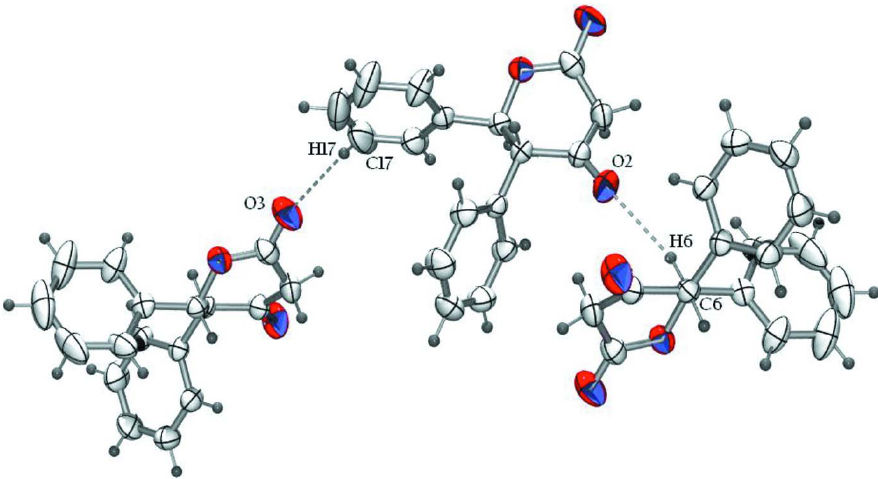
H O , showing the atom labelling with 50% probability displacement. 17 14 3